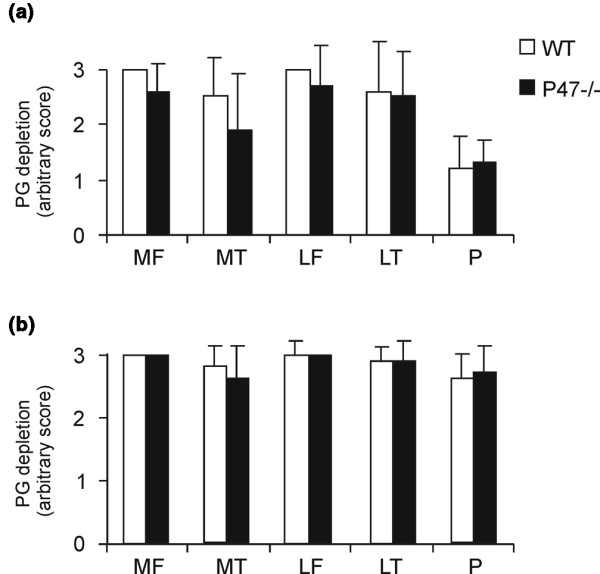
Proteoglycan loss from various cartilage layers of inflamed knee joints. Loss of red staining was scored in tibia, femur and patella on an arbitrary scale from 0 to 3. Data are expressed as loss of red staining in comparison with control cartilage layers, and are means ± SD for eight mice; they were tested for significance with the Wilcoxon rank test (*P < 0.05). No significant difference in proteoglycan loss was found on day 3 (a) or day 7 (b) between wild-type controls and p47phox-/- mice. LF, lateral femur; LT, lateral tibia; MF, medial femur; MT, medial tibia; P, patella.